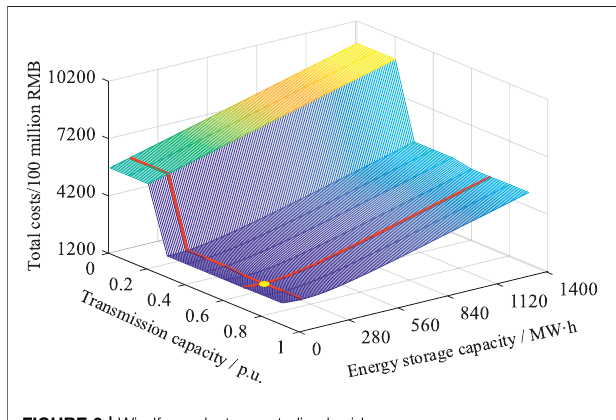
FIGURE 9 | Windfarm cluster centralized